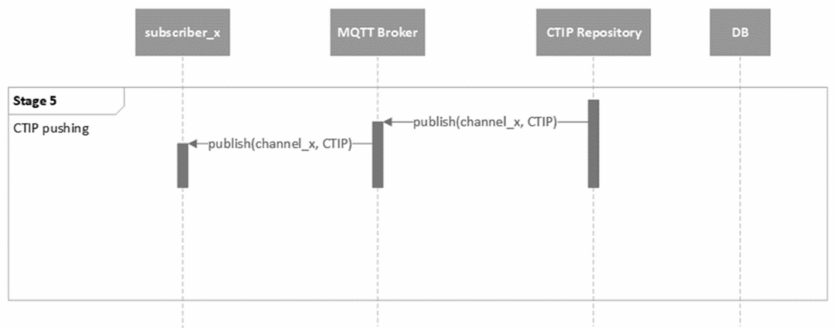
Figure 14. UML behavioral diagram of the CTIP pushing stage (stage